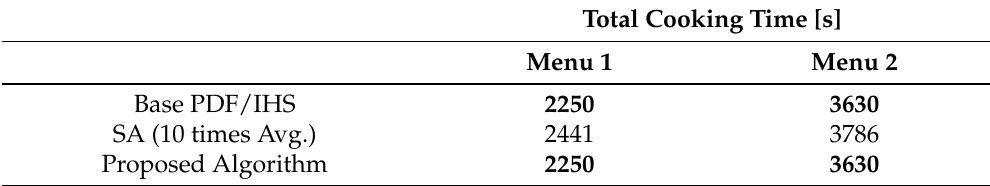
Table 3. Total cooking time obtained by the algorithm.